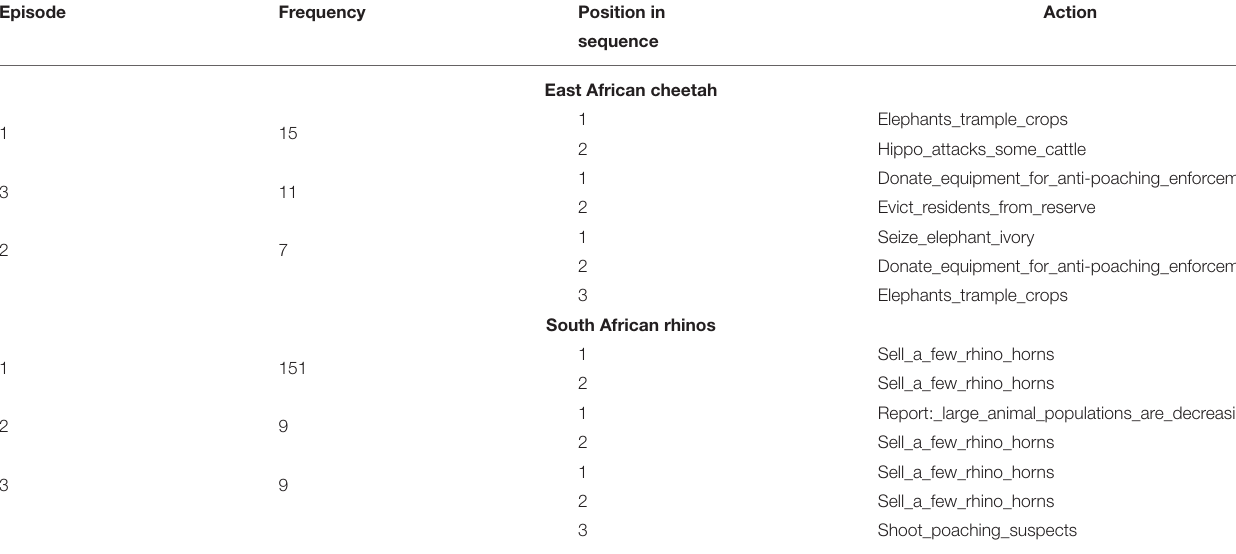
TABLE 3 | A selection of frequent, multi-action episodes in the East African cheetah, and South African rhino actions history data sets. Episode Frequency Position in Action